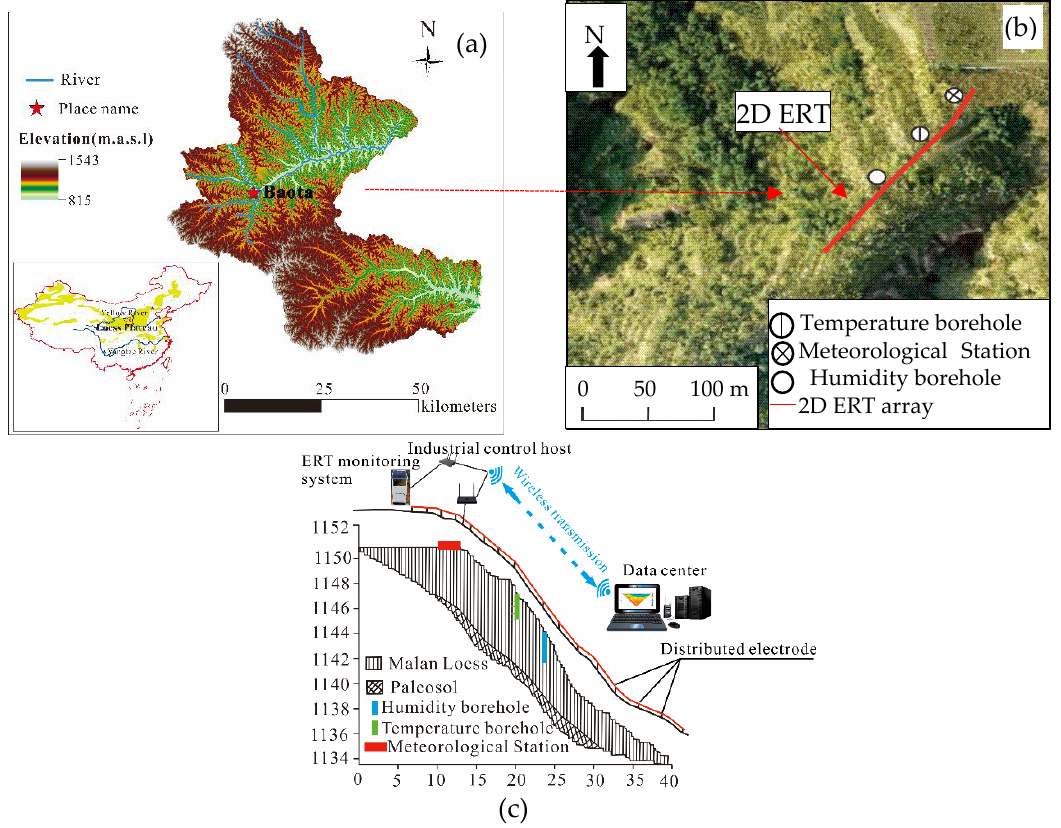
Figure 1. Study site: ( a ) a map of the Chinese Loess Plateau, showing the locations of the Baota District; ( b ) site plan showing aerial photographs of the study area and the location of the 2D electrical resistivity tomography imaging array, other monitoring facilities and borehole locations; ( c ) electrical resistivity tomography layout plan of the slope in the study area. ERT is the acronym of electrical resistivity tomography.